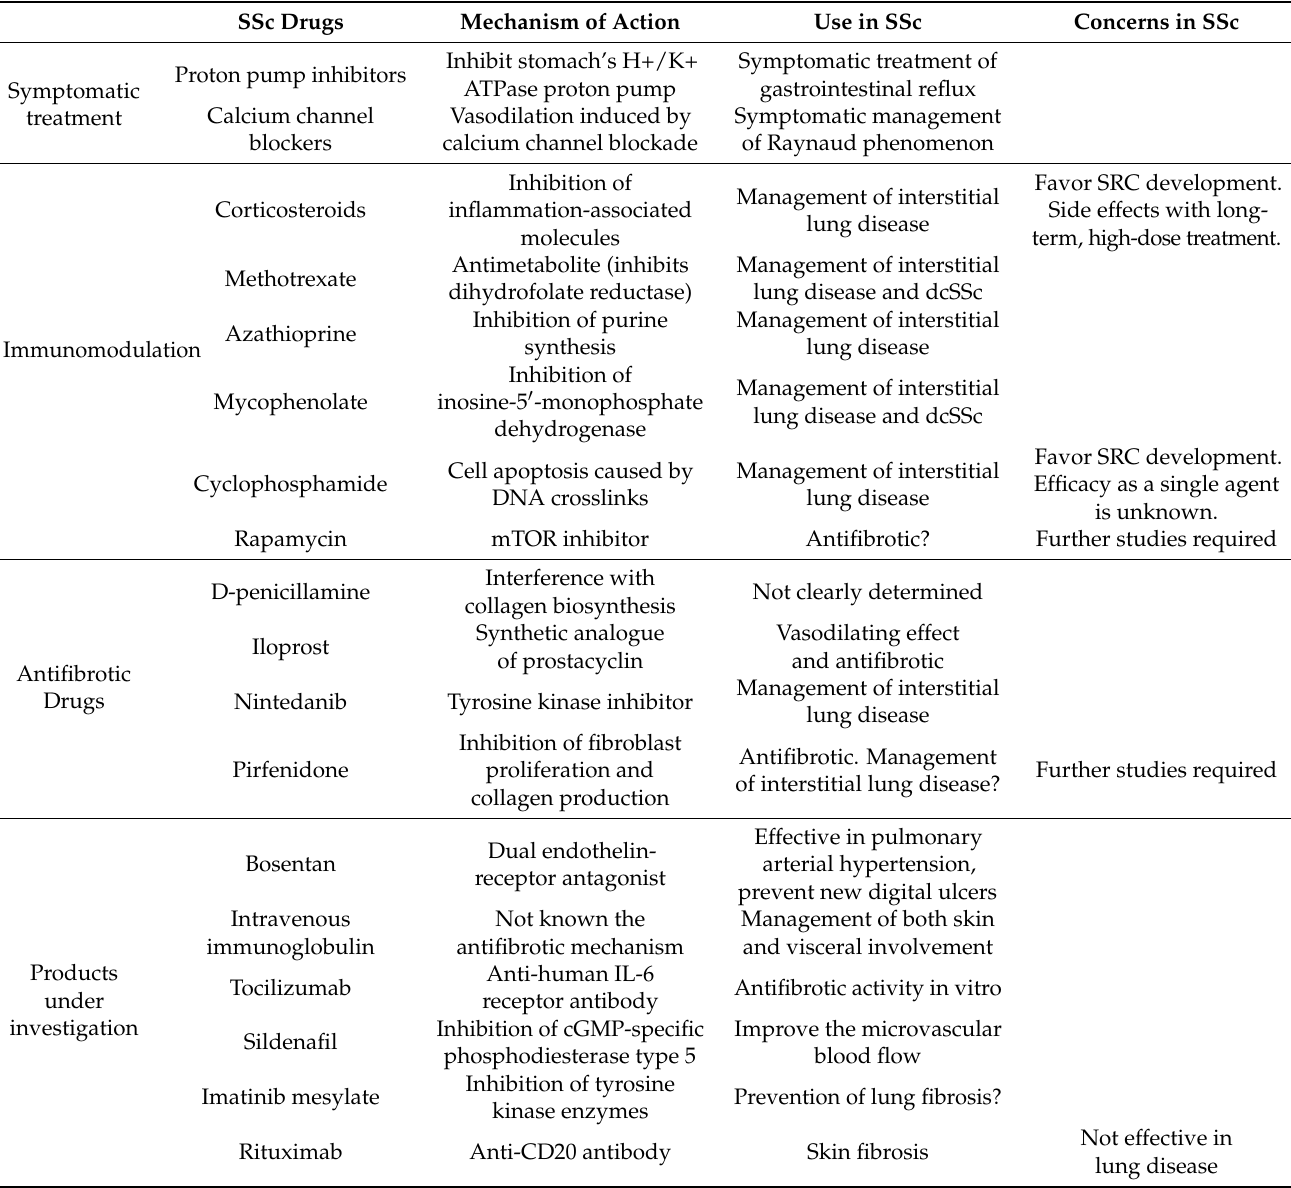
Table 1. Main characteristics of drugs currently used or under investigation in systemic sclerosis (SSc). cGMP, cyclic guanosine monophosphate (cGMP); dcSSC, diffuse cutaneous systemic